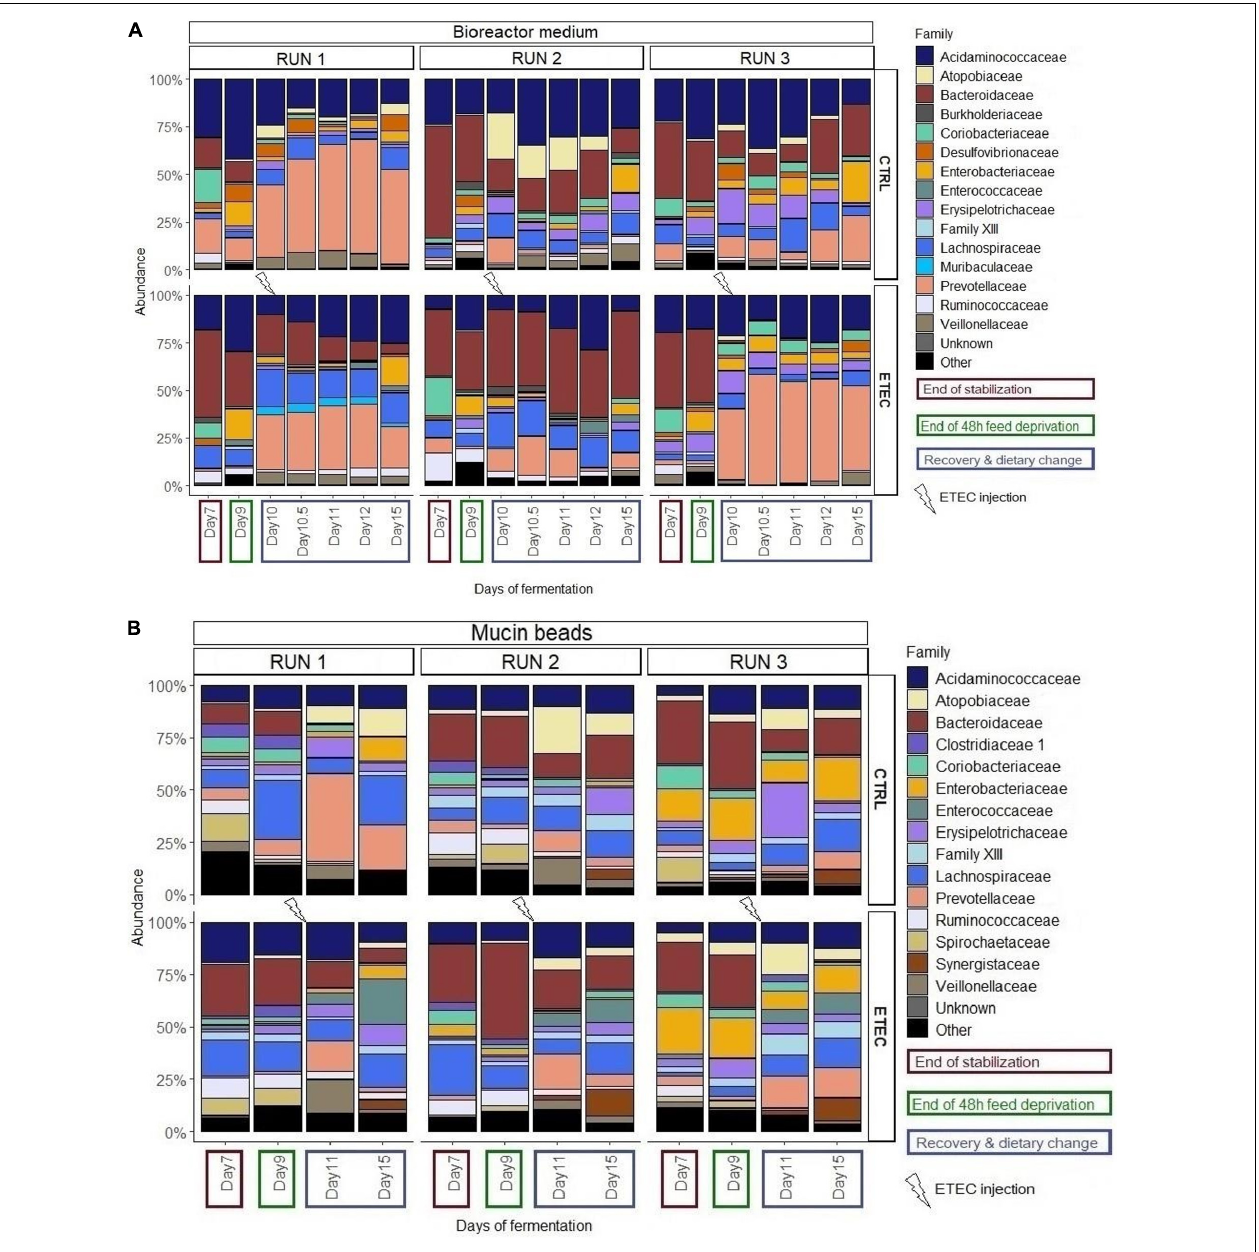
FIGURE 5 | Relative abundances of the main bacterial families in the bioreactor medium (A) and the mucin beads (B) in MPigut-IVM during the runs #1, 2, and 3 which were subjected to a simulated weaning transition and challenged or not with the ETEC Ec105